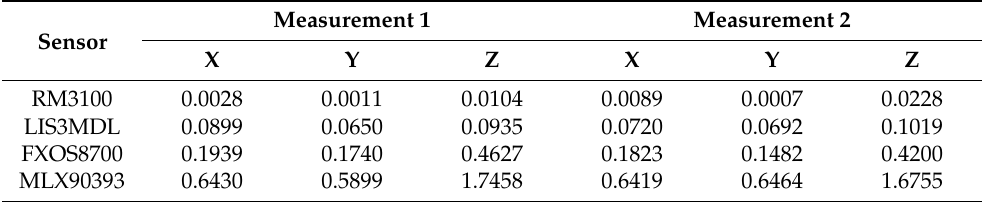
Table 4. Amount of noise in real conditions [ µ T 2